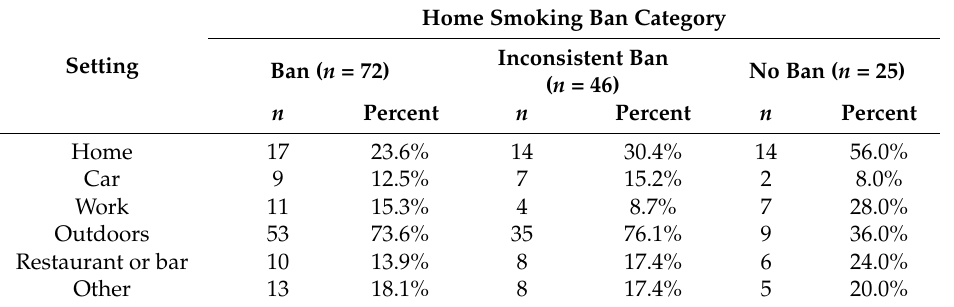
Table 2. Self-reported past 2 month tobacco smoke exposure settings among nonsmokers with detectable NNAL levels ( n =